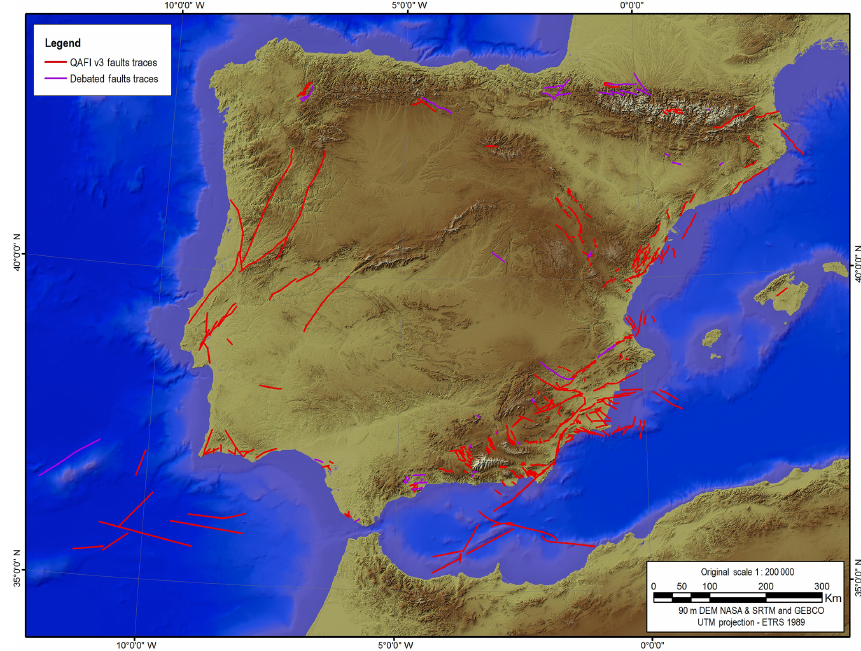
Figure 1. Representation of the QAFI v.3 and Debated Faults databases. Users can query both databases online in